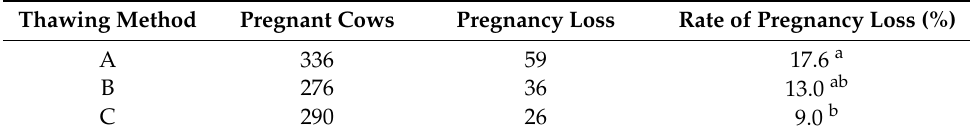
Table 3. Total of pregnant cows, number of pregnancy losses, and pregnancy loss rate (in %), according to the thawing method (A = 11 s, 38 °C water bath; B = 35 s, 38 °C water bath; C = 30 s, “in the cow”). Thawing Method Pregnant Cows